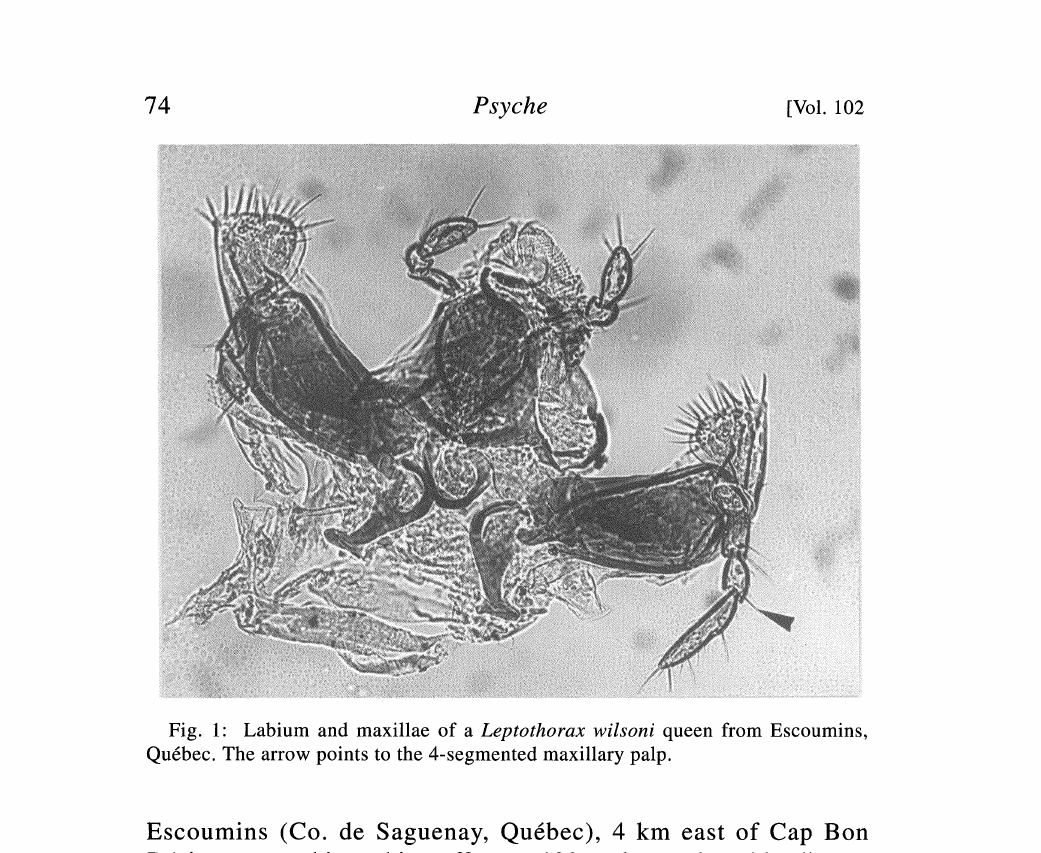
Escoumins (Co. de Saguenay, Qu6bec), 4 km east of Cap